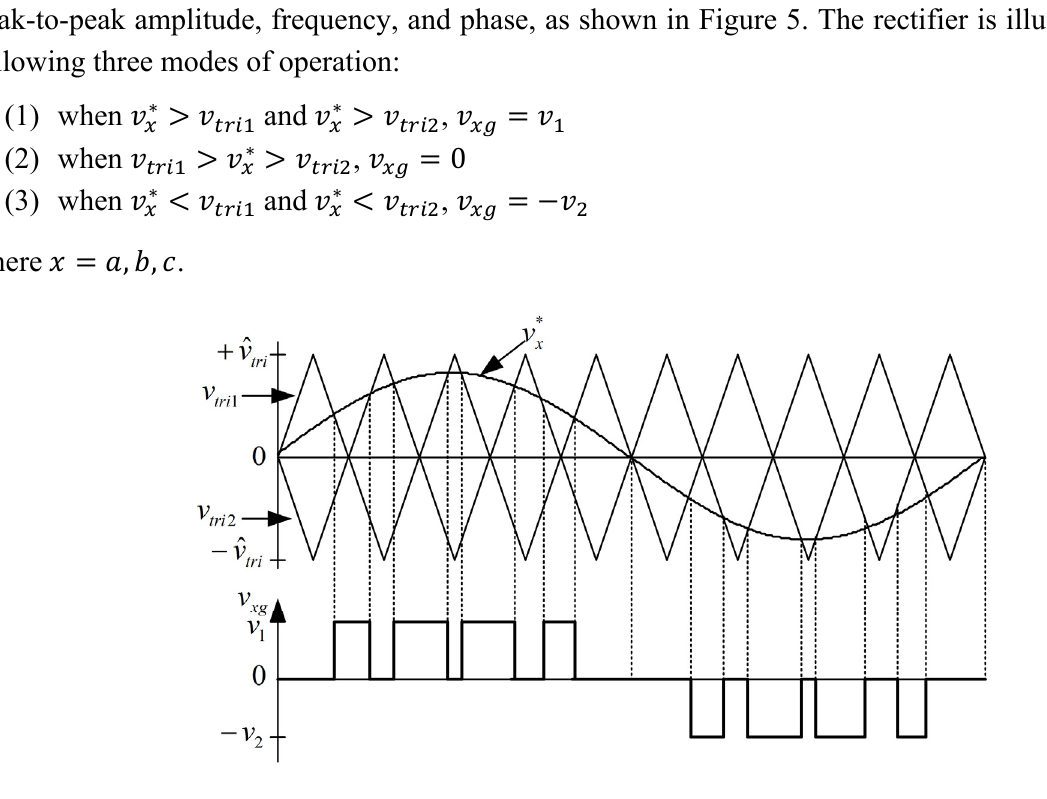
Figure 5. Sinusoidal PWM with two carrier